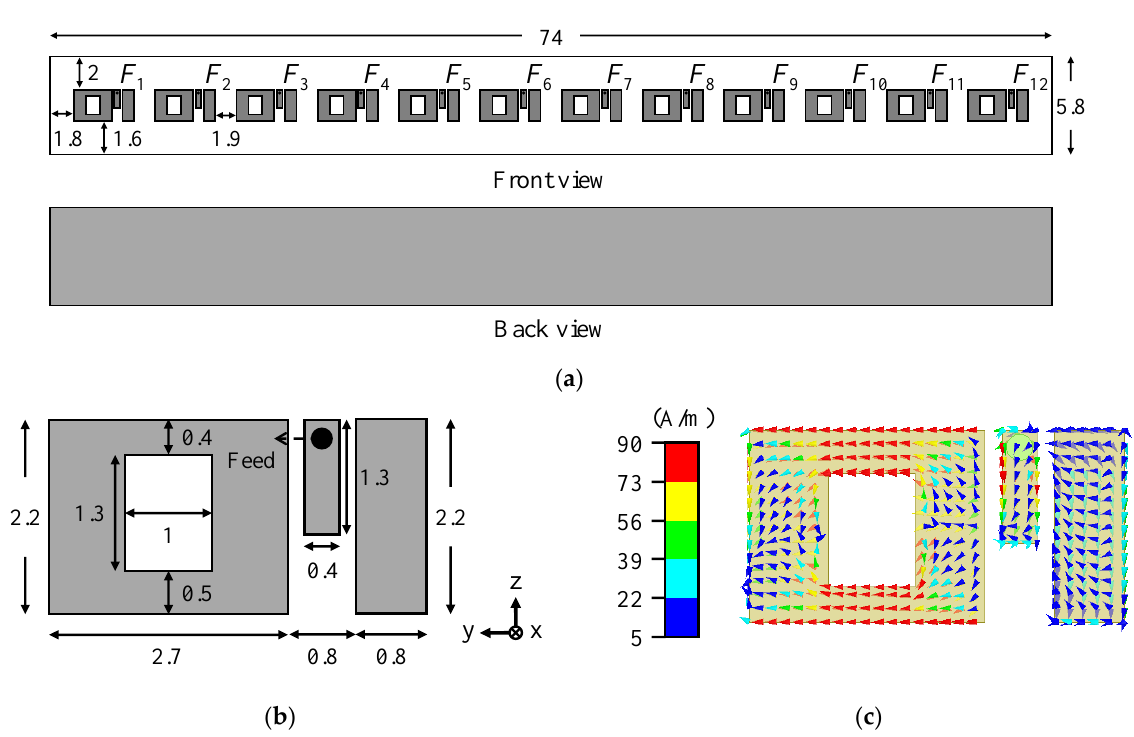
Figure 2. Geometry of ( a ) the 28 GHz 1 × 12 coupled patch antenna array and ( b ) the unit element (all measurements are in mm). ( c ) The surface current distributions at 28 GHz.